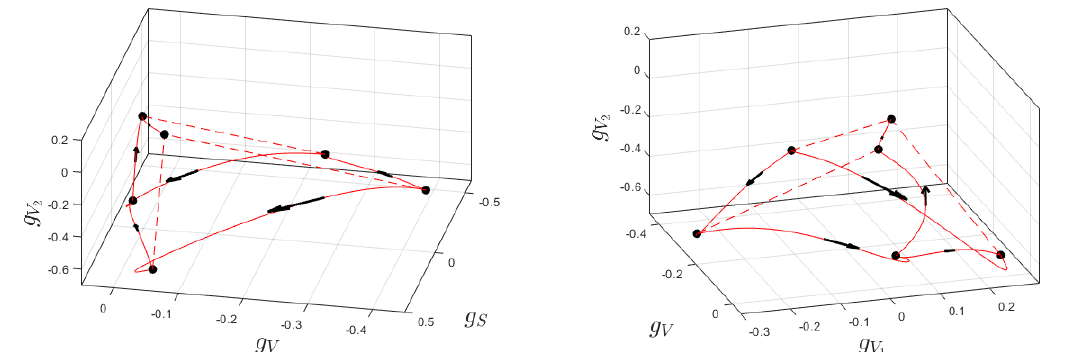
Figure 12. Fixed points and critical heteroclinic orbits of the QCD (3 ; 13) and (cid:11) g = (cid:11) nt . Solid line: heteroclinic connections. Dashed lines: heteroclinic connec- g tions that are expected to exist, but have not been found numerically. Left: projection on the ( g S ; g V ; g V )-space. Right: projection on the ( g V ; g V 2